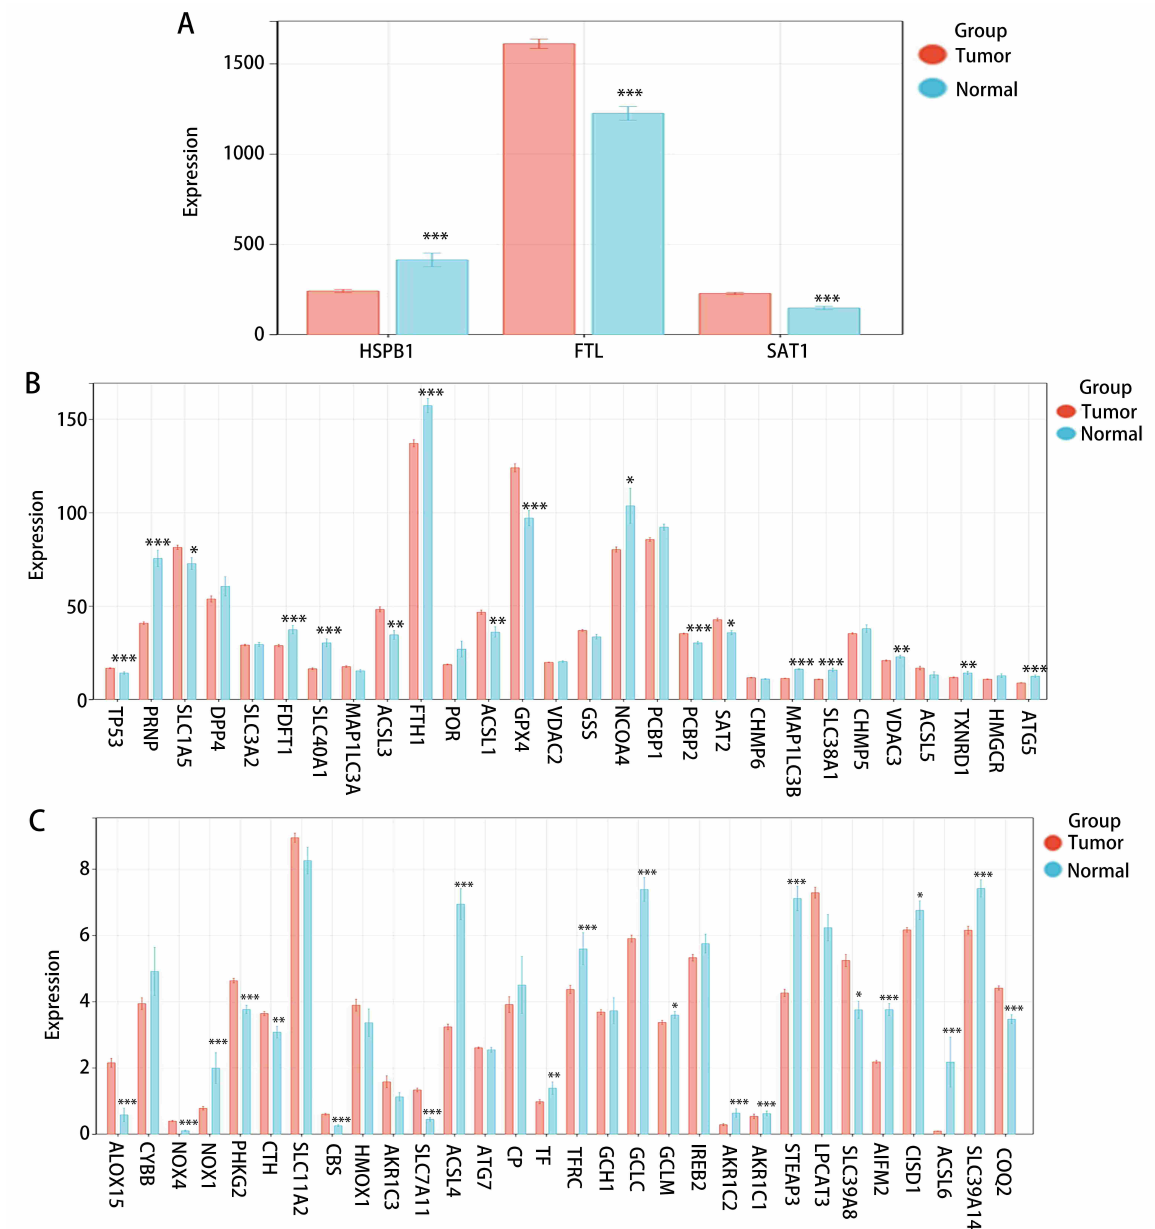
FIGURE 1. The expression of 64 FRGs in tumor and normal tissues. * p < 0.05, ** p < 0.01, *** p < 0.001. predict the prognosis of PRAD, namely TFRC, FTH1, PCBP2, ACSL3, PRNP and LPCAT3 (Table 1). Based on multivariate Cox coefficients and expression value, a risk model was estab- lished. The 6-signature risk score = 0.108 × TFRC + 0.007 × FTH1 + 0.026 × PCBP2 − 0.007 × ACSL3 − 0.021 × PRNP − 0.074 ×